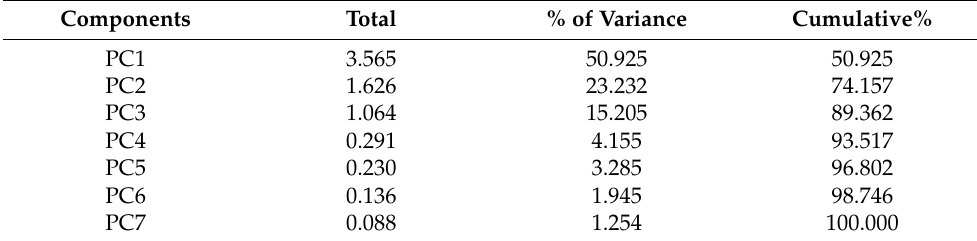
Table 9. Total variance